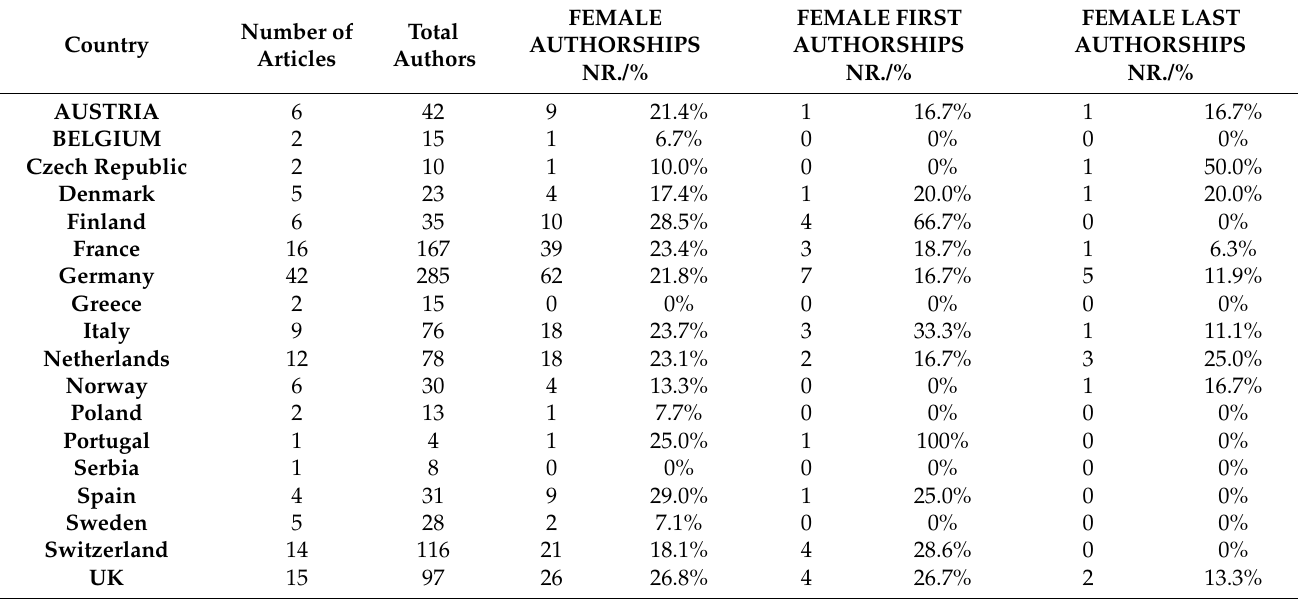
Table 1. Details for female participation dependent on the specific European country in alphabetical order. Female authorships are listed as a percentage of total authors. Articles with female first and last authorships are listed as percentage of the number of articles of the corresponding